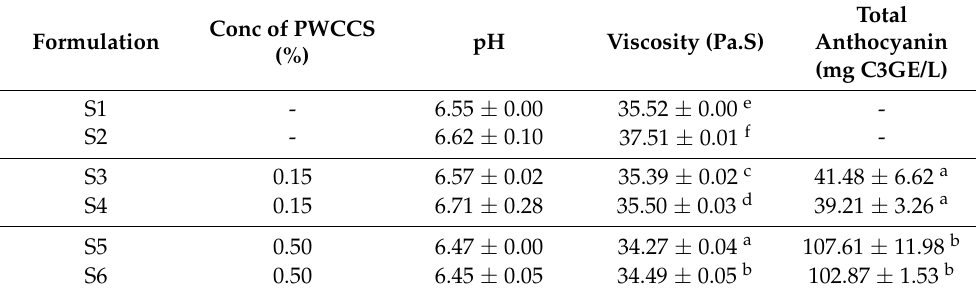
Table 1. Physical characteristics of formulations